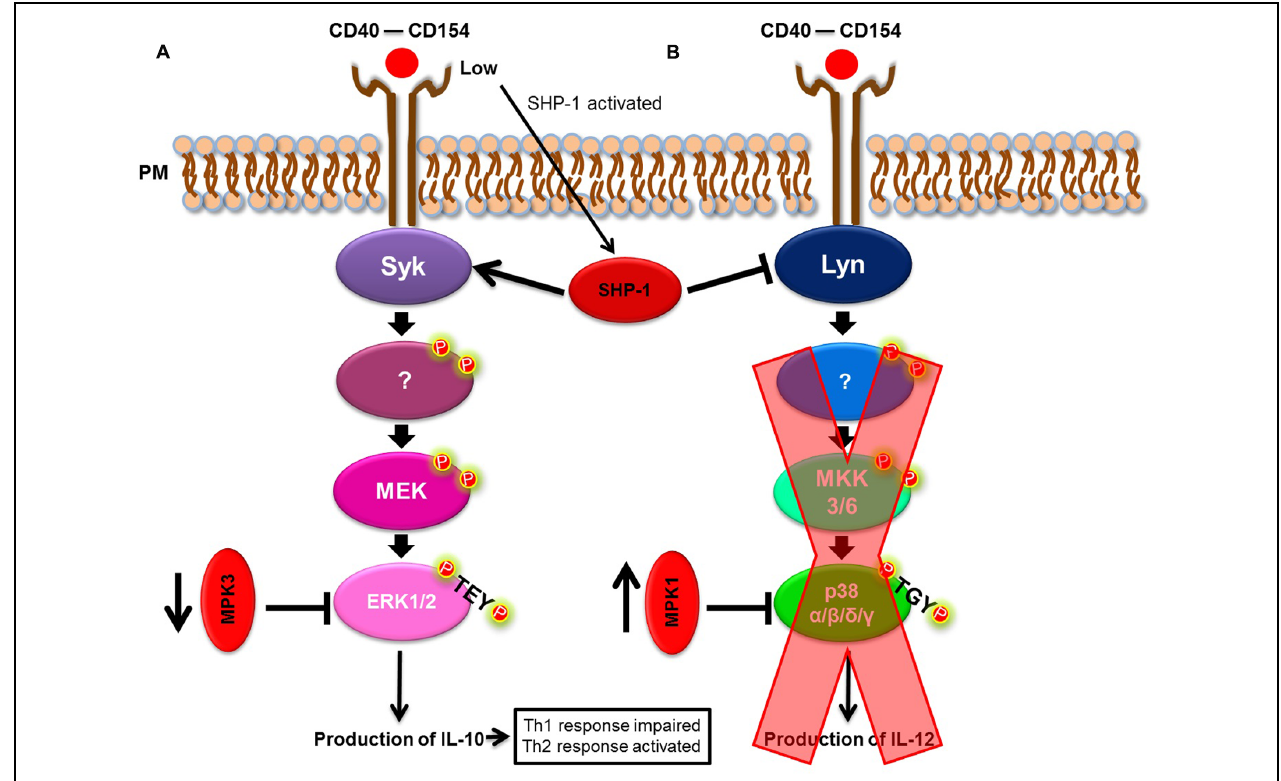
FIGURE 2 | Leishmania spp. model of immune modulation targeting the p38/ERK1/2 MAPK pathway. (A) CD40/ERK1/2 pathway. (B) CD40/p38 MAPK pathway. Leishmania spp. skew the CD40/MAPK signaling pathway, from p38 to ERK1/2, to favor IL-10